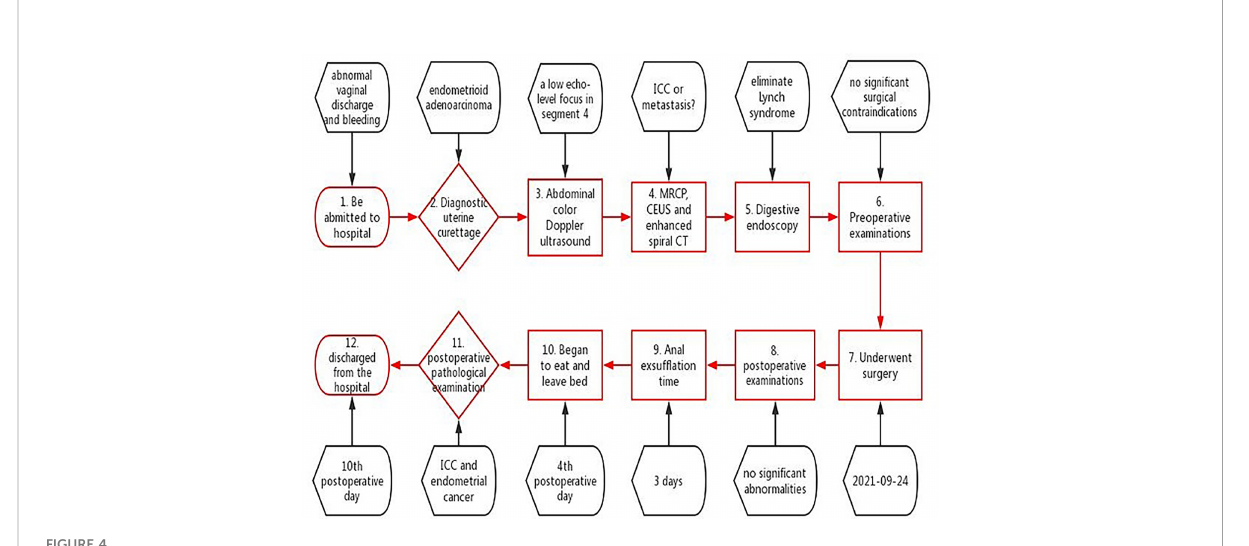
FIGURE 4 Information of care organized as a